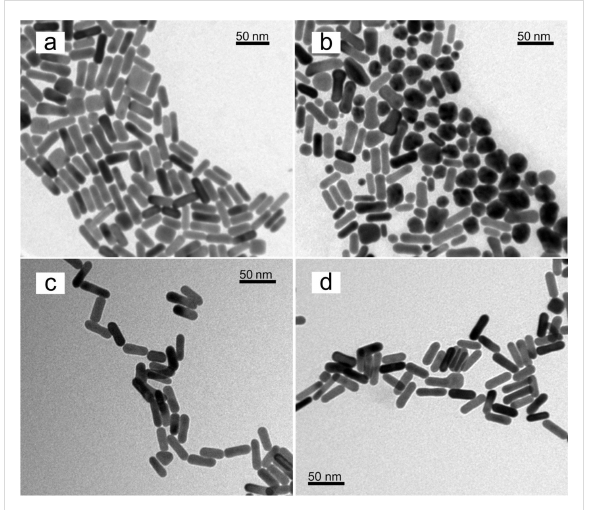
Figure 2: TEM images of (a) as-synthesized AuNRs, (b) AuNRs washed 4 times by centrifugation, (c) PEGylated AuNRs and (d) PEO–PPO–PEO encapsulated